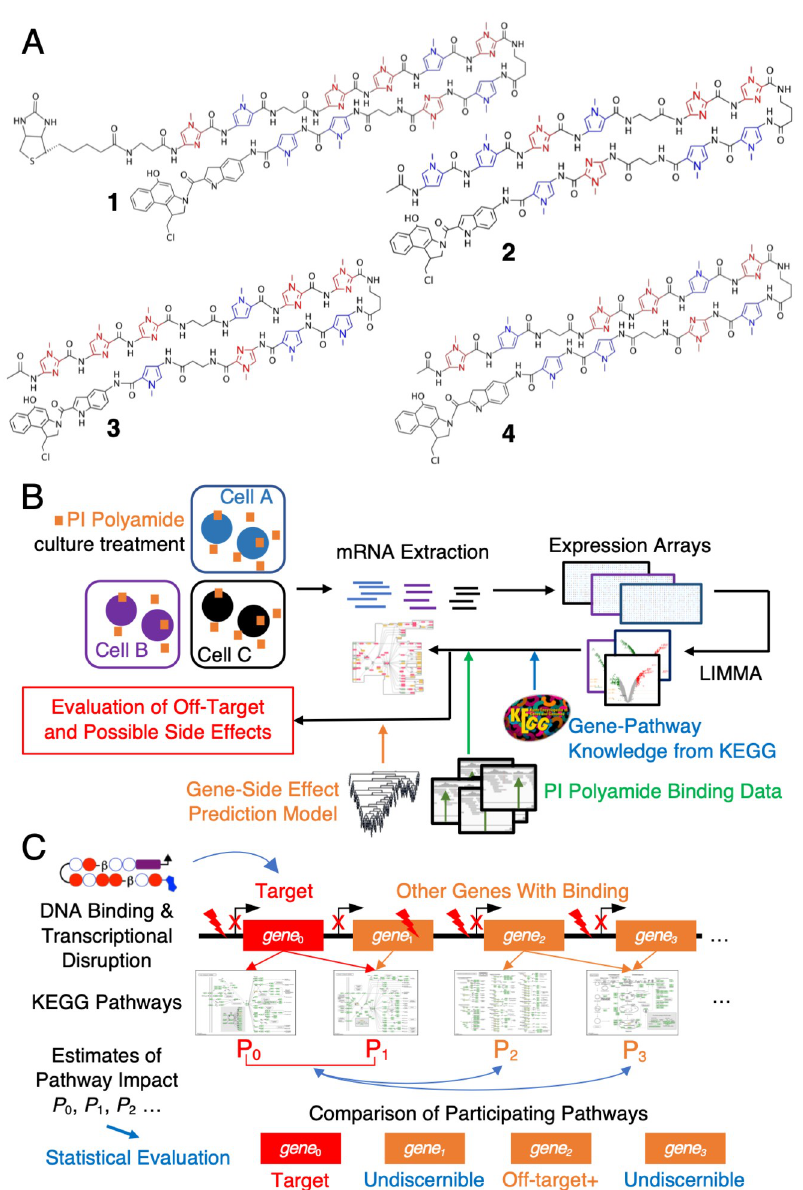
Fig 1. Design of a pathway-based method to evaluate off-target effects for PI polyamides. (A) Structure of candidate PI polyamides: 1 , designed to target G12D/V KRAS mutants; 2 , a polyamide seeking to bind E545K PIK3CA mutation; 3 , a polyamide meant to suppress MYCN amplifications; 4 , unbiotinylated version of polyamide 1 used for in vivo validation experiments. N -methylpyrrole subunits, blue; N -methylimidazole subunits, red. (B) Scheme of automated systematic Analysis; (C) concept of pathway-based evaluation.